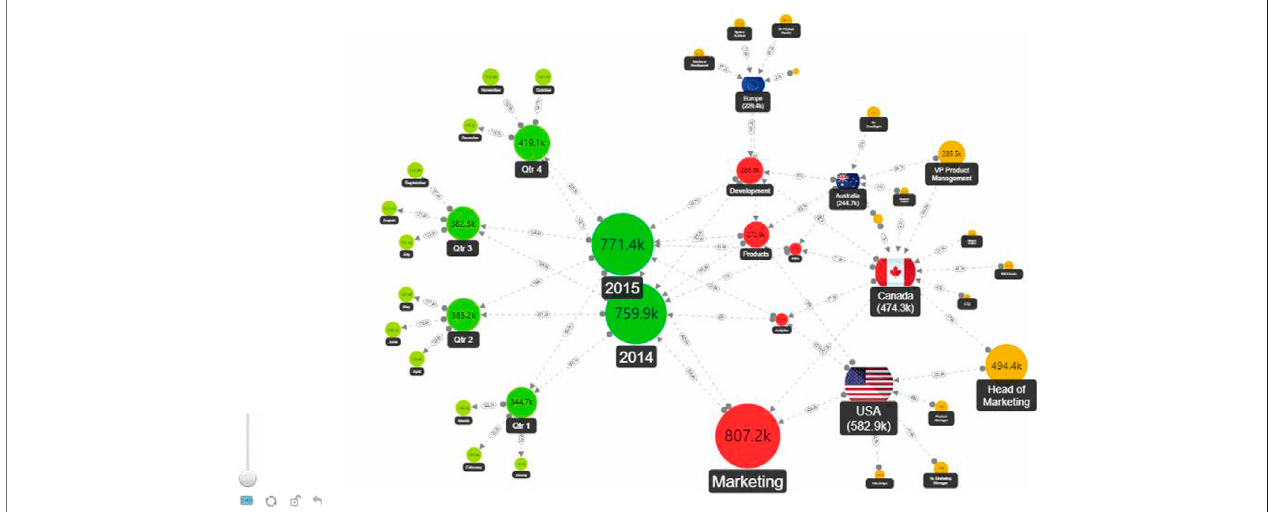
FIGURE 6 | Screen capture of interactive ZoomCharts Network Chart Custom Visual for Microsoft Power BI which is supported on all platforms and can be implemented and customized by the user (ZoomChart, 2020).